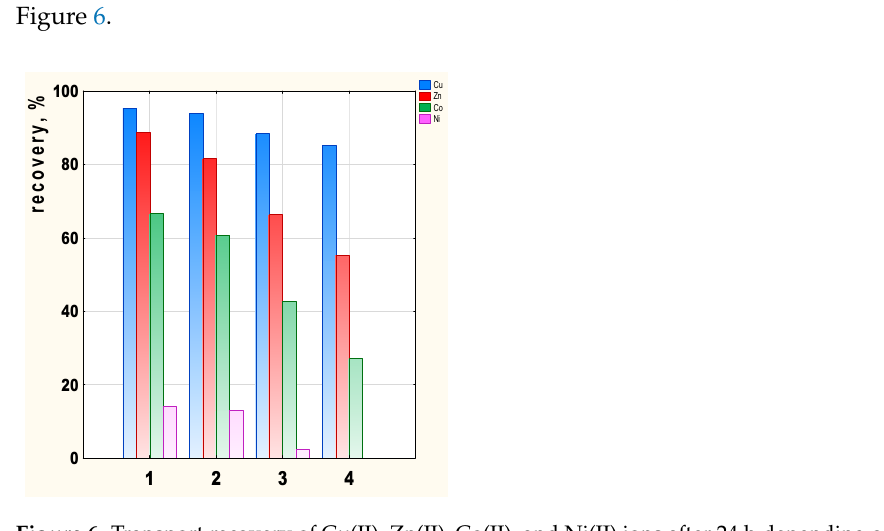
cm 2 /s (Table 5) is smaller than the value of 1.5 × 10 − 7 cm 2 /s reported for the Pb(II) complex